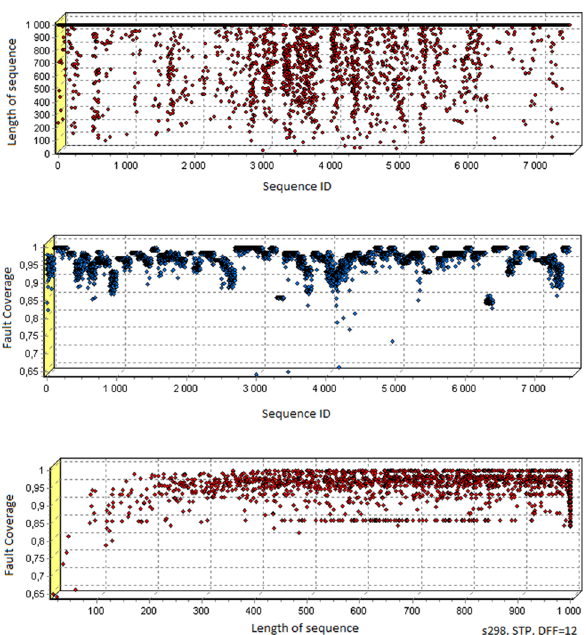
Fig. 35 STP for s298 with use of 14 internal